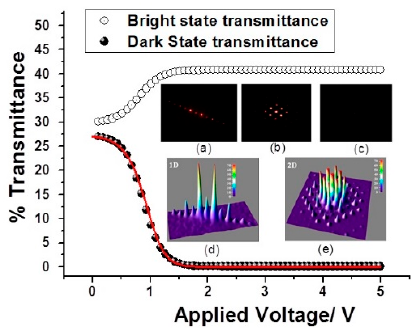
Figure 24. The dependence of first order transmittance on electric field in bright and dark state of ESH grating theoretically (solid line) and experimentally (dotted line). Insertions: Di ff raction pattern of ( a ) 1D grating, ( b ) 2D grating and ( c ) black state; ( d , e ) are intensity profiles of 1D and 2D gratings measured at V = 5 V [47].